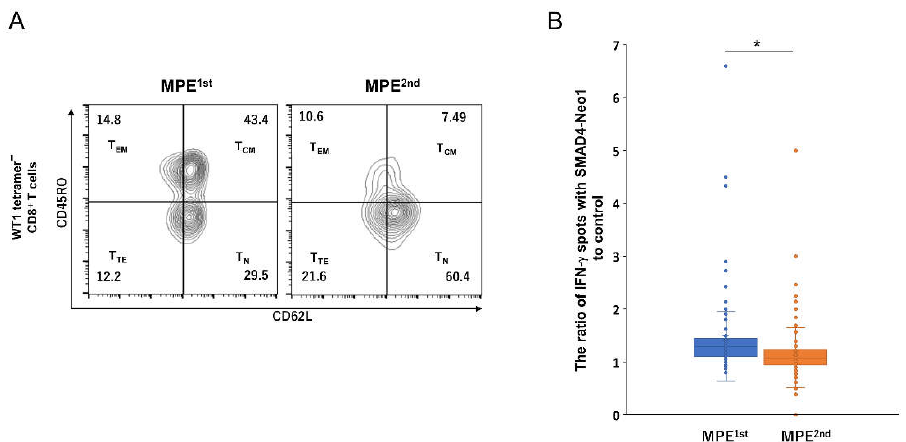
Figure 4. Memory subsets of WT1 tetramer − CD8 + T cells and detection of SMAD4 P130L -specific CD8 + T cell expanded from MPE samples. ( A ) WT1 tetramer - CD8 + T cells in MPE 1st or MPE 2nd were stained with antibodies against CD62L and CD45RO for memory T cell subsets. ( B ) WT1 tetramer – CD8 + T cells were sorted from MPE 1st or MPE 2nd , expanding in vitro with HPL-IFN-DCs containing SMAD4-Neo1 peptide. These cells were stimulated with SMAD4-Neo1 or DMSO to detect IFN-γ-producing cells by ELISpot assay. The ratio of IFN-γ spots of SMAD4-Neo1 to control was shown in the box plot (per each well in 96 plates). Mann–Whitney U test, * p < 0.05.